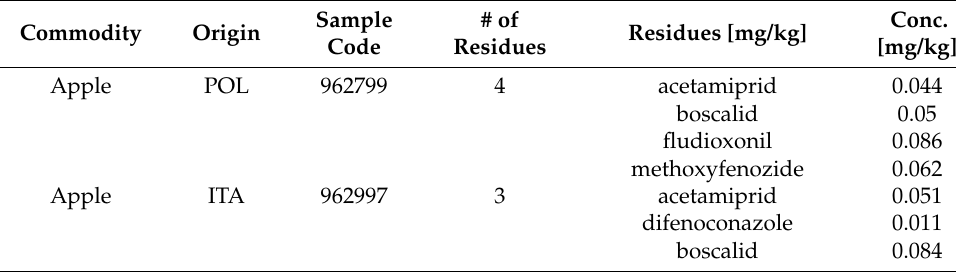
Table A10. Details of multiple residues ( ≥ 2) in single samples.